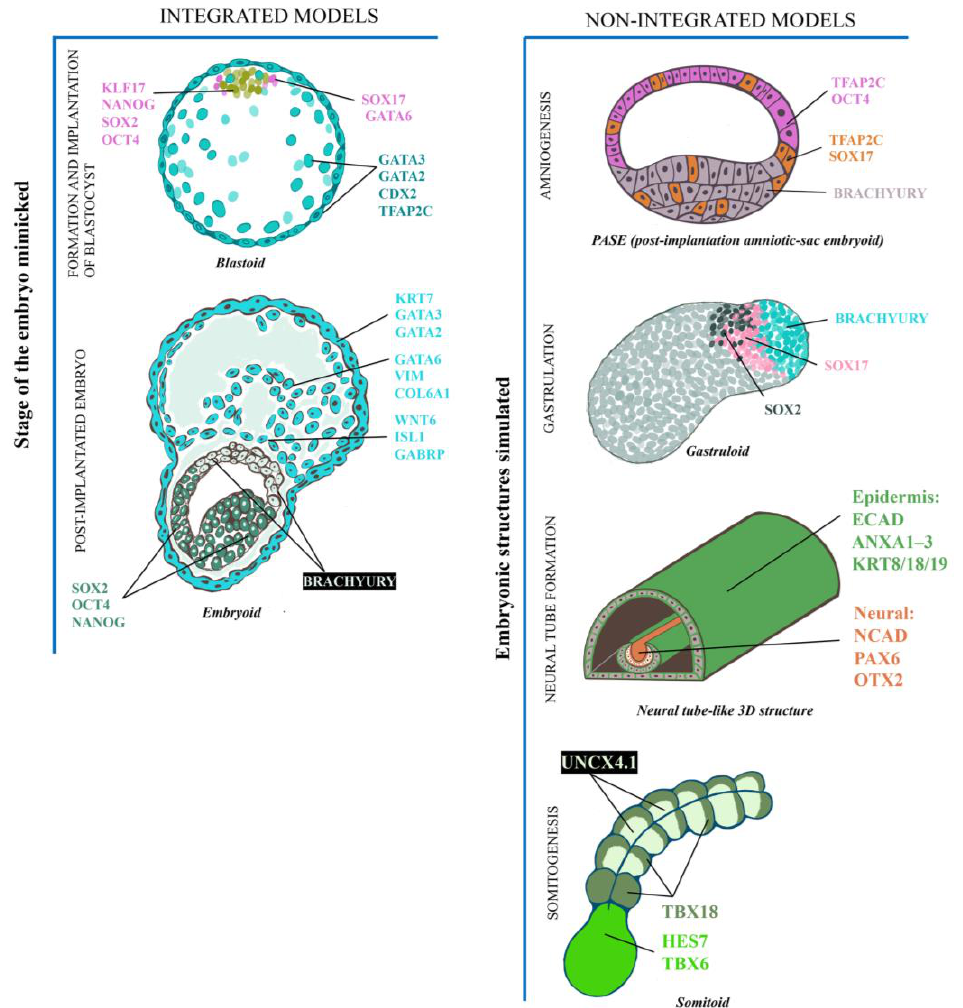
Figure 2. Modeling human embryogenesis with 3D stem cells-based structures. The 3D structures derived from human pluripotent stem cells (embryonic stem cells and induced pluripotent stem cells) are capable of recapitulating both a complete embryo (integrated by embryonic and extraembryonic lineages) as well as events (amniogenesis, gastrulation) or specific structures (neural tube, somites) of the embryo. The blastoids [36,45,47] present the three lineages that make up the blastocyst, each identified by the expression of specific genes (KLF17, NANOG, OCT4 and SOX2 for epiblast-like cells (golden lime color); SOX17 and GATA6 for hypoblast-like cells (purple kush color); GATA3, GATA2, CDX2 and TFAP2C for trophectoderm-like cells (turquoise color). Embryoids [48] presented a columnar epithelium corresponding to epiblast (privet hedge color) (OCT4, NANOG, SOX2) surrounded by a mix of extraembryonic-like cells (pluviophile color) (KRT7, GATA2 and GATA3 for trophectoderm; GATA6, COL6A1 and VIM for extraembryonic mesoderm; ISL1, GABRP, WNT6